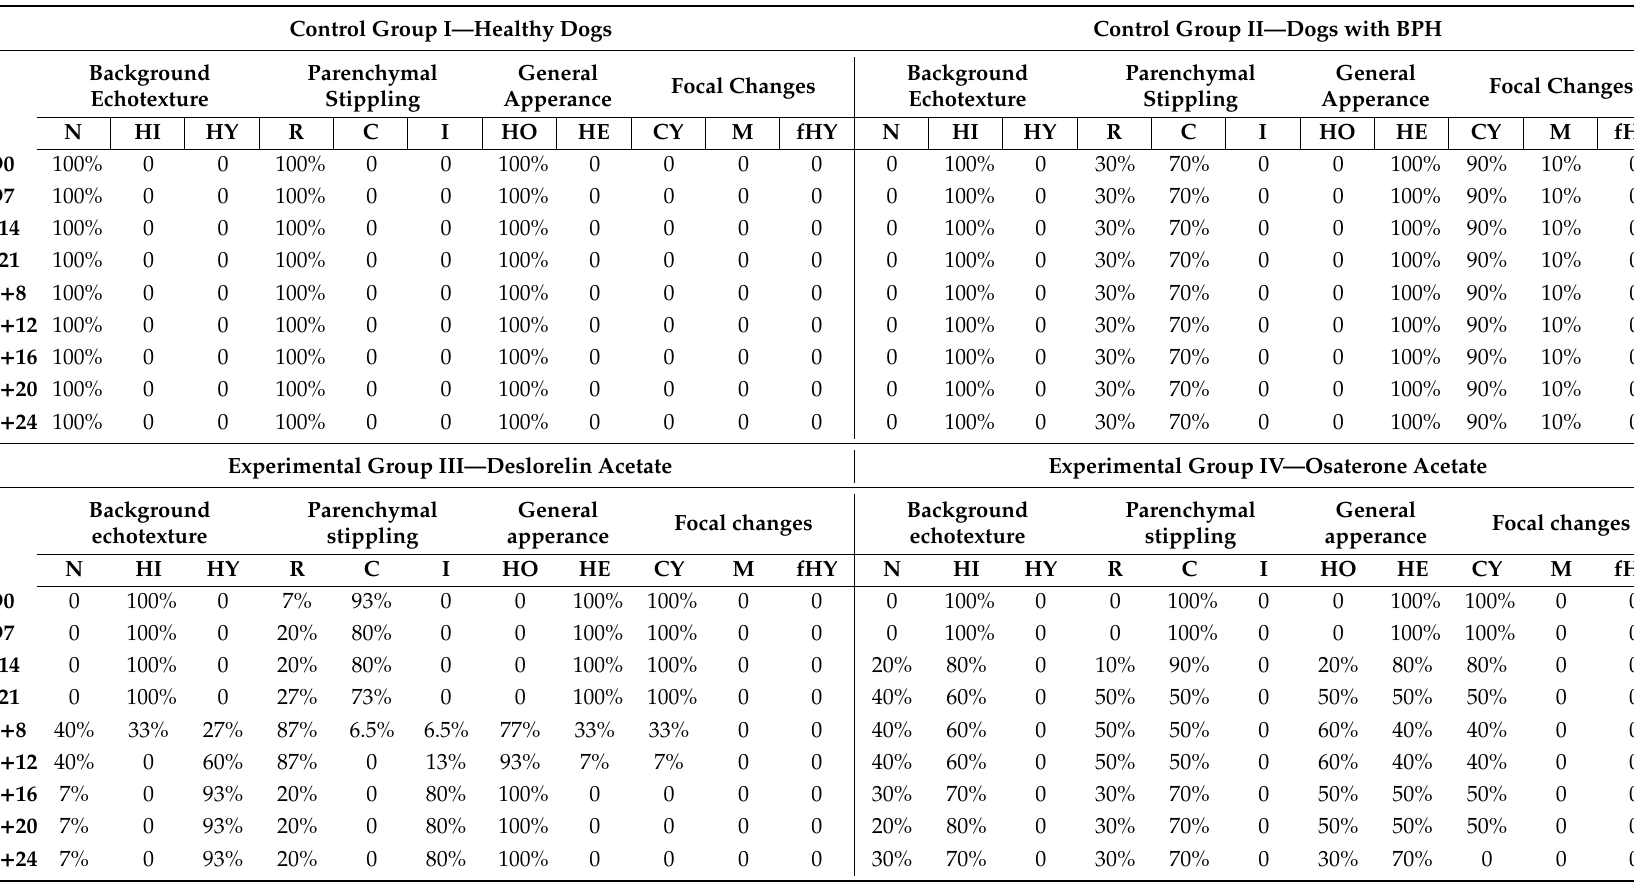
Table 1. Subjective assessment (0%—none; 100%—present in the entire image) of prostate gland parenchyma in B-mode imaging after Russo [14], in Control Groups I and II, and Study Groups III and IV during 24 weeks of